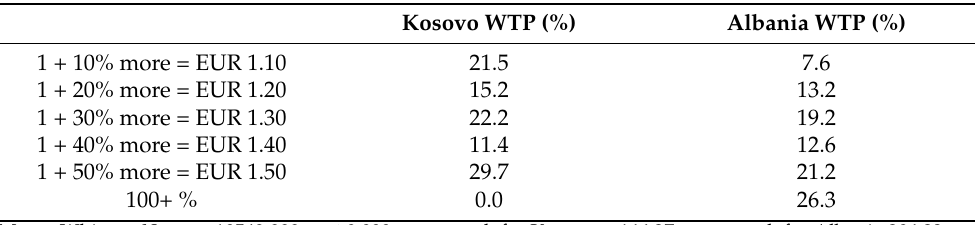
Table 3. Respondents WTP for fresh foods instead of